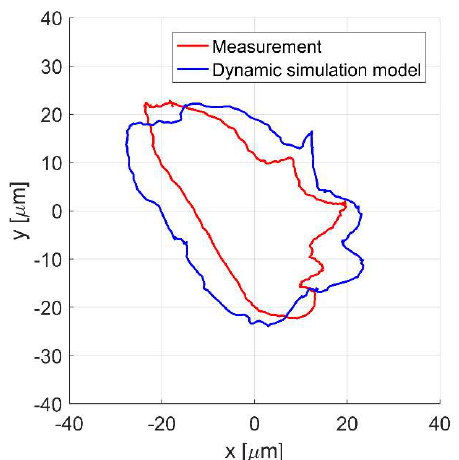
Figure 14. The rotor position in x and y axes for the rotor rotation with 4724 rev/min.